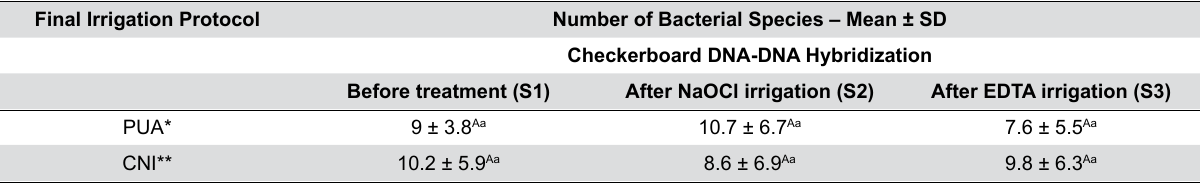
Figure 4- Stacked bar chart of frequency and DNA concentration of individual bacterial species investigated before root canal treatment (S1), and after instrumentation (S2 and S3). The total length of each bar indicates the percentage of positive samples. Different colors within each bar indicate the percentage of samples containing different concentrations of bacterial DNA Table 2- Effectiveness of PUA and CNI protocol in removing bacterial species in primary endodontic infection (Uppercase – Different columns; lowercase – different